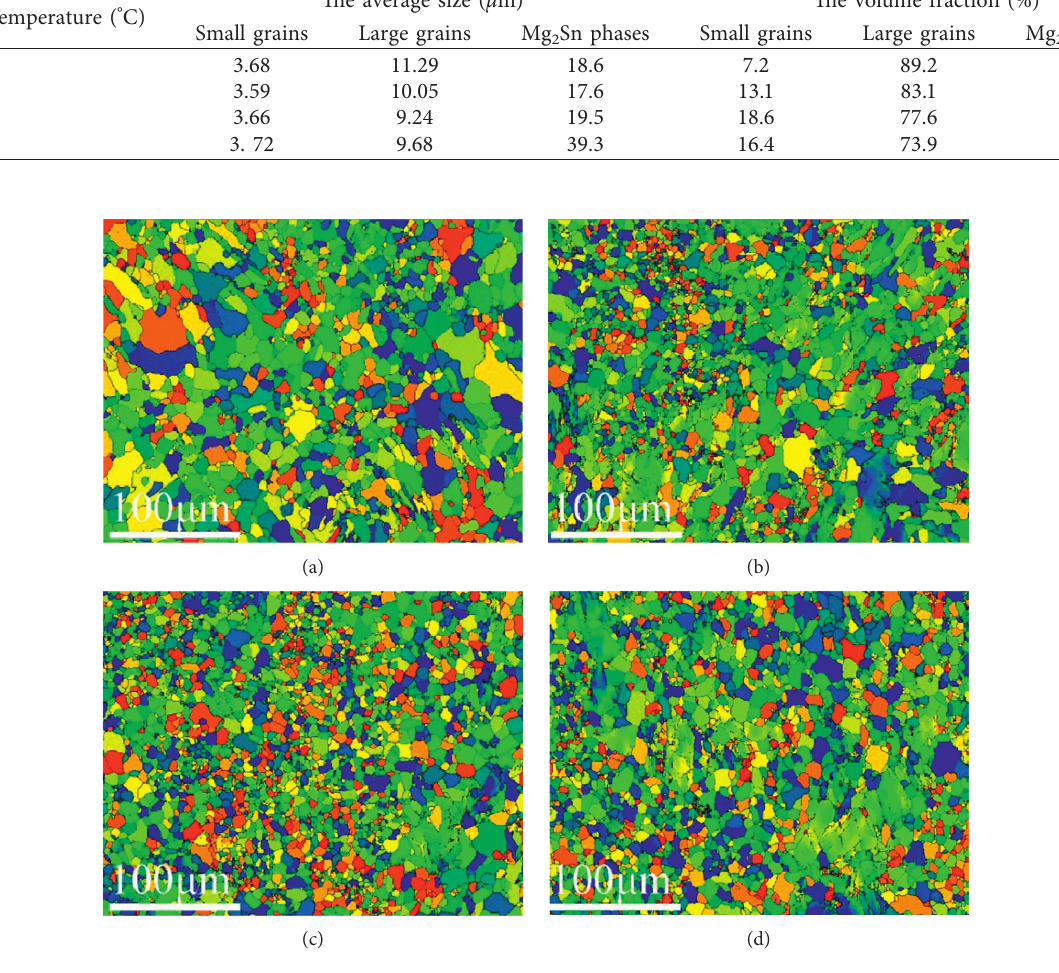
Figure 5: EBSD images of the as-rolled Mg-6Sn-3Al-1Zn alloys at different rolling temperatures: (a) 300 ° C, (b) 350 ° C, (c) 400 ° C, and (d) 450 ° C.